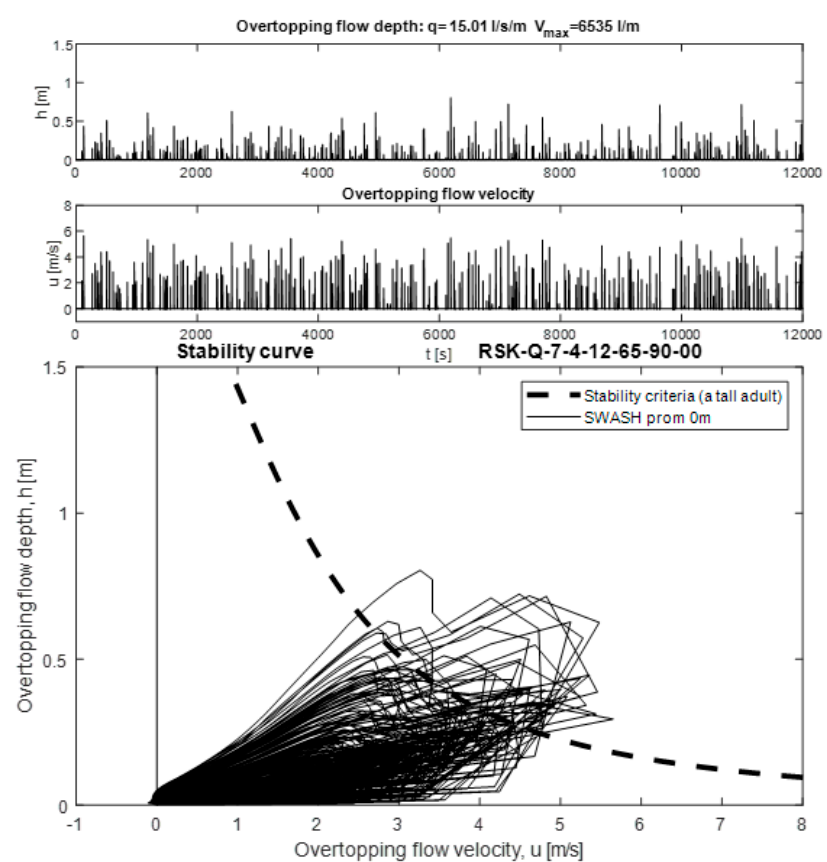
Figure 8. Time series of h and u (the first and second figures) and h-u relationship calculated in SWASH versus stability curve of a tall adult (the third figure): RSK_Q_7_4_12_65_90_00 (a case in which V is around 6500 l/s/m, and the promenade width of 0 m).